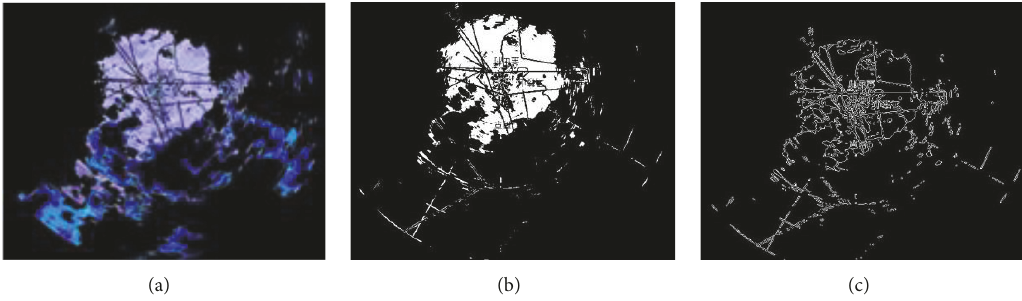
Figure 7: From (a) to (c): image after extracting the blue elements, corresponding binary image, and contour lines.